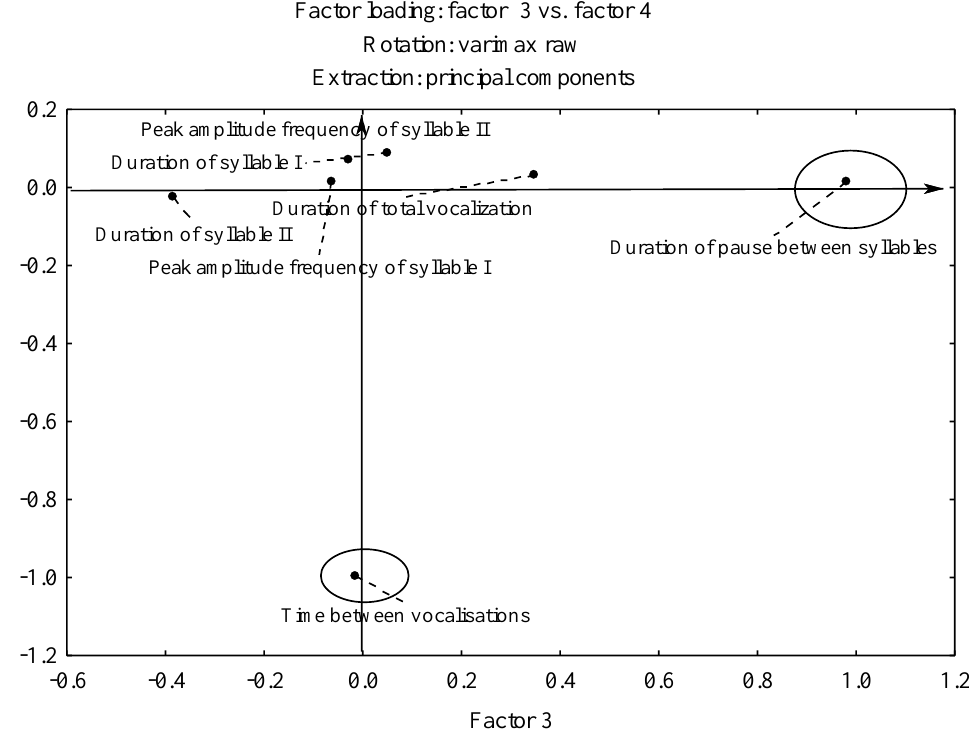
Figure 5. The plot of the projection of the variables onto the planes of the third and fourth factors after Varimax rotation. after Varimax